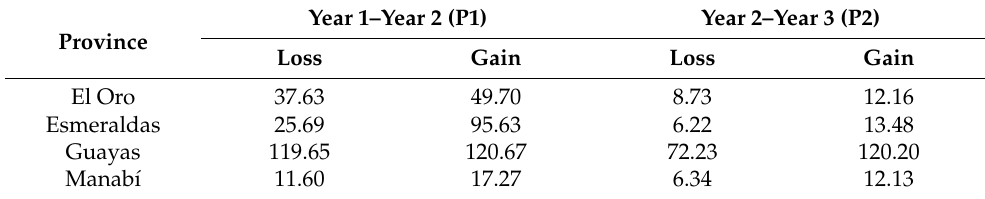
Table 8. Mangrove gross losses and gains by province